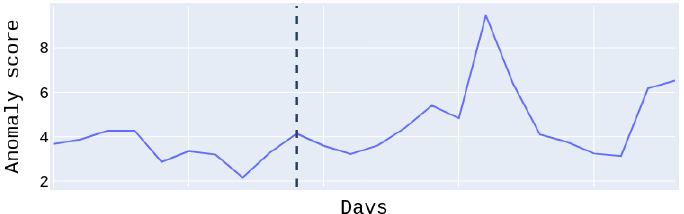
Figure 11. Anomaly score of Patient #1. Note that the Days on the x-axis are not continuous.